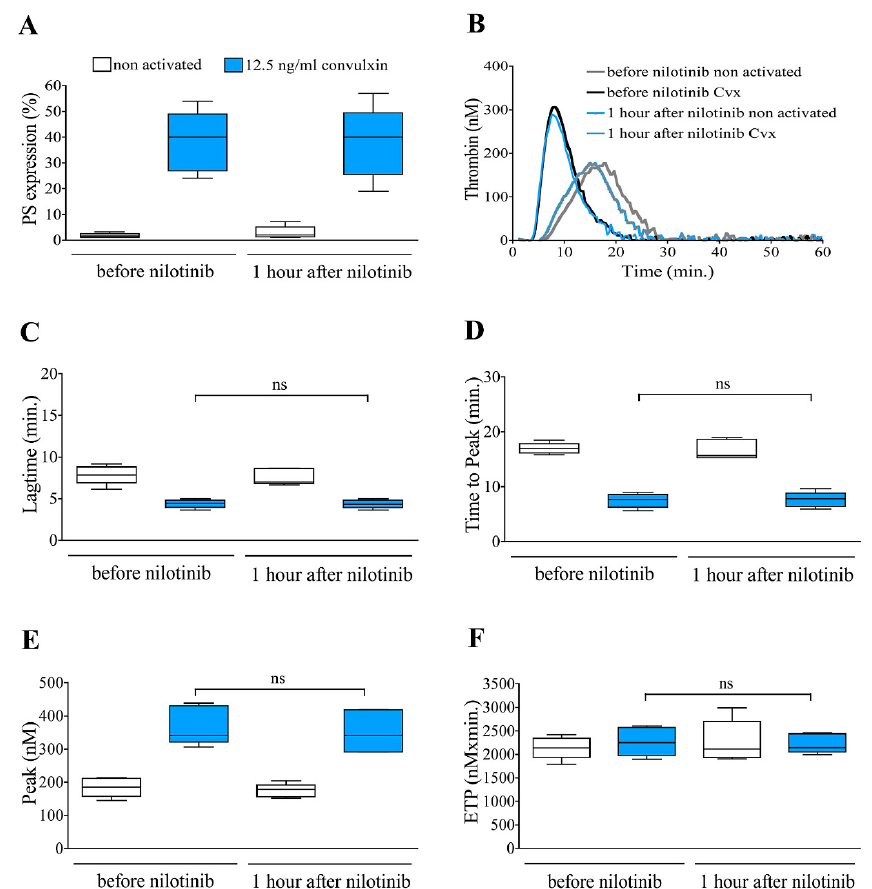
Figure 4. Nilotinib treatment does not affect PS expression and thrombin generation in PRP of CML patients. Samples were from nilotinib treated CML patients ( n = 5) before and at 1 h after witnessed drug administration. Platelets of patients were stimulated with convulxin for 15 min in PRP. PS exposure ( A ) and thrombin generation were investigated. Panel ( B ) shows representative overlay thrombin generation curves. Time parameters of thrombin generation, lagtime ( C ); time to peak ( D ); and quantity of generated thrombin, peak ( E ) and ETP ( F ), were evaluated.